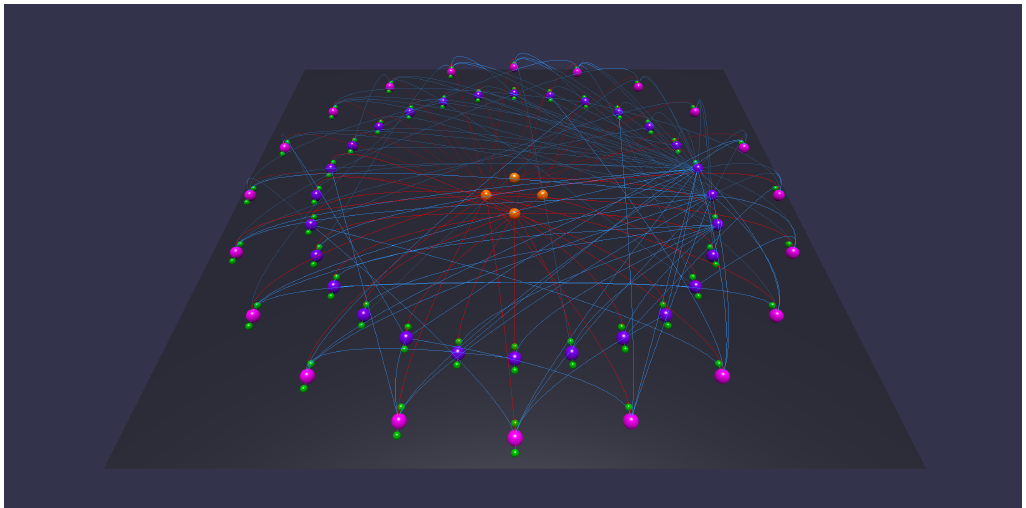
Figure 14. Use Case #3: The unfiltered knowledge base of the reification use case.